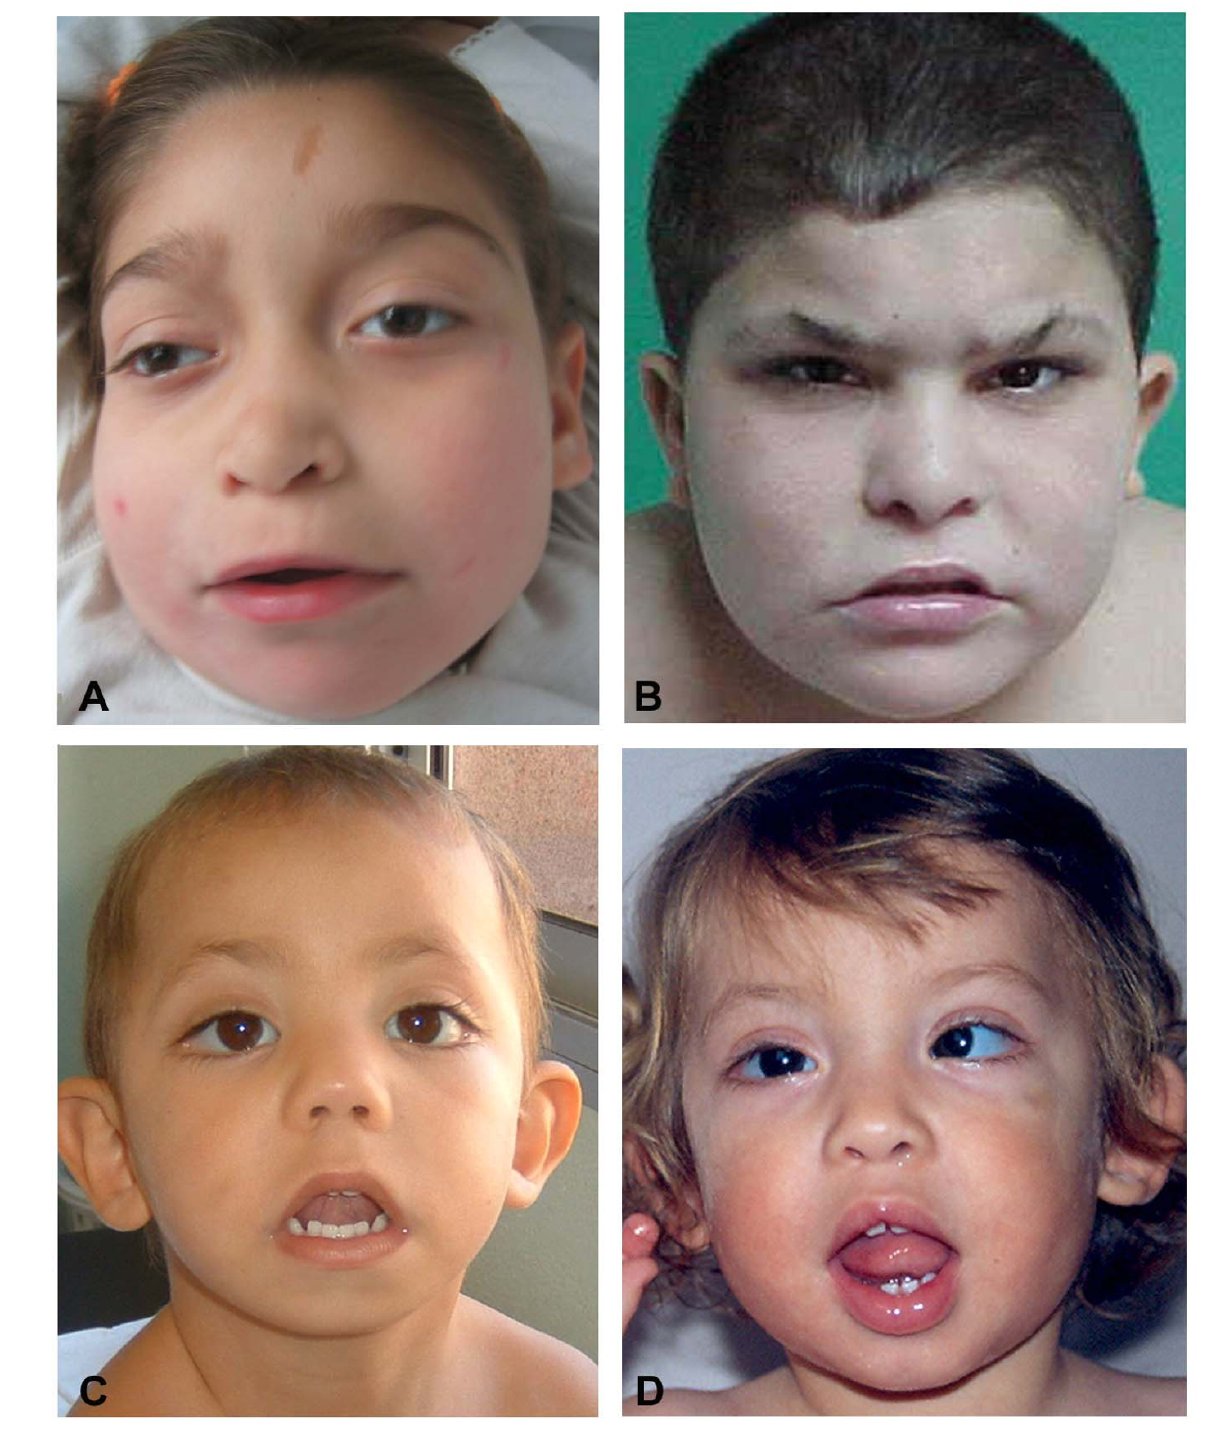
Figure 1 Facial phenotype of 2 Kabuki-like (A:KS2; B:KS14) and 2 Kabuki patients (C:KS7; D:KS12). Note that KS2 and KS14 also show some features characteristic of the 2q37